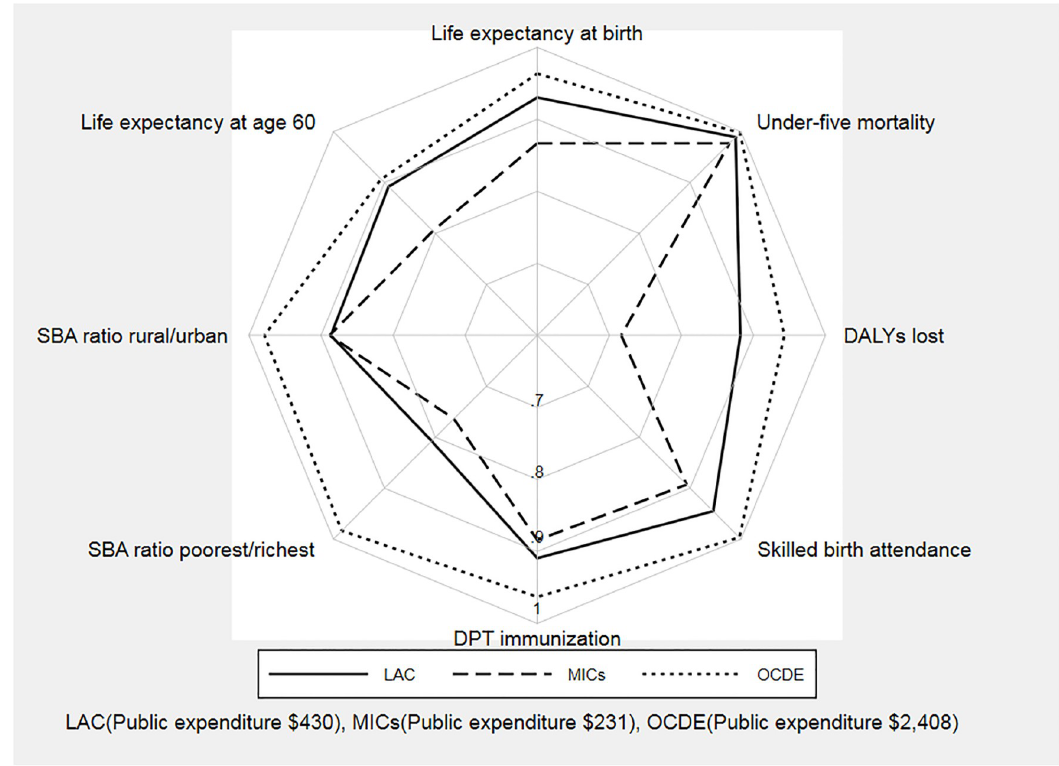
Fig 3. Comparison of average efficiency scores: LAC, OECD and